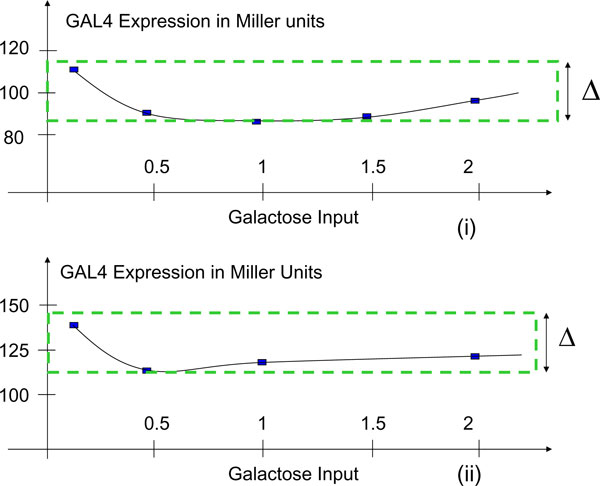
nonmonotone nonlinearity in Kluveromycetes lactis. We experimentally observed that the synthesis of  using galactose in Kluveromycetes lactis exhibits the shown nonlinearity. WT culture was grown in different concentrations of lactose and galactose in liquid culture. The concentrations used were 0.1%, 0.5%, 1%, and 2%. The beta-galactosidase activity was measured in different concentrations of sugar by a protocol described by Miller method (see [20]). The maximum enzyme activities at different concentrations are plotted; the plots are not to scale.